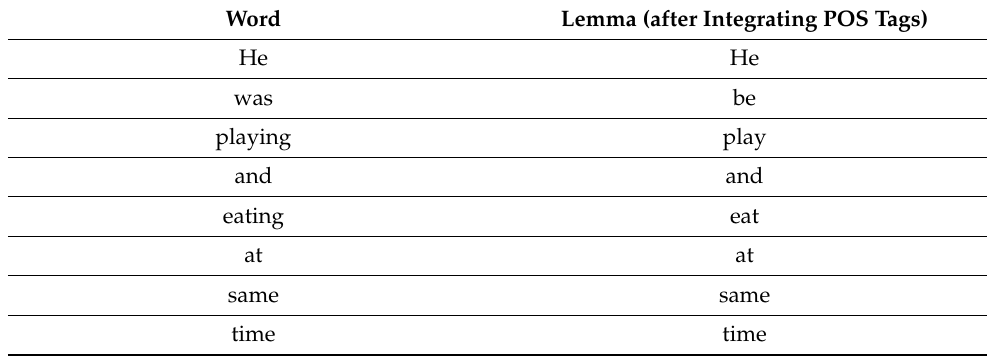
Table 6. Word to root word conversion using POS tagging and